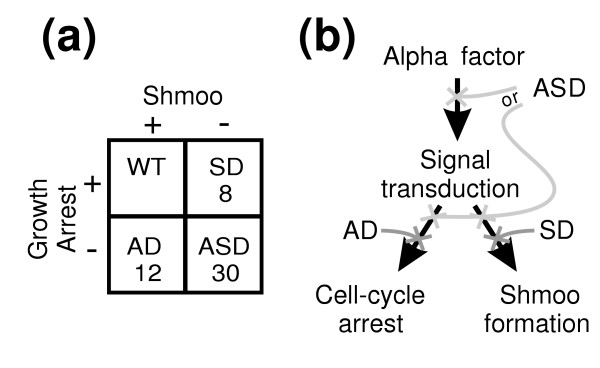
Summary of cell-chip/growth assay results. With two phenotypic screens, we expected three classes of mutants: true-positive alpha factor-response pathway mutants (ASD), those defective only in the shmoo pathway (SD), and those defective only in the growth arrest (AD). (a) The number of genes identified in each category; (b) their interpretation. Only 413 strains were tested by growth assay, so the number of strains with wild-type phenotypes (WT) is omitted.